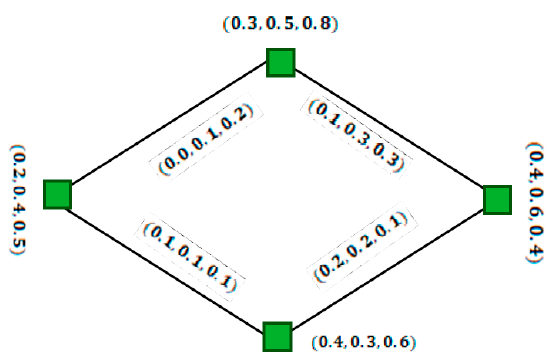
Figure 19. Complement of the graph depicted in Figure 18.